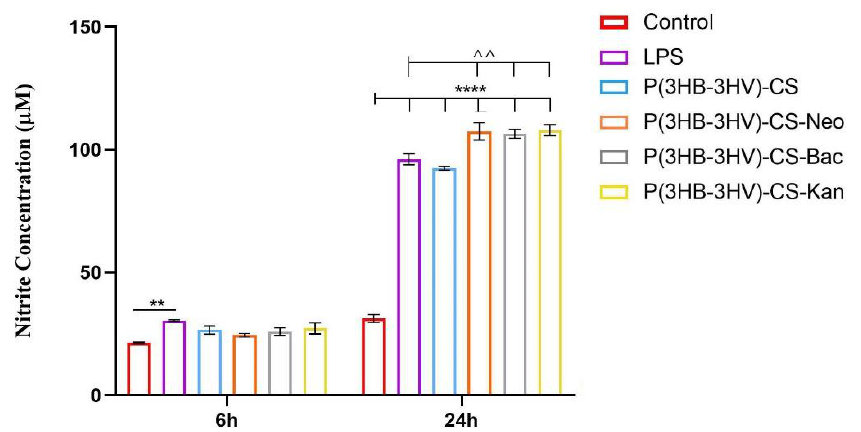
Figure 8. Graphic representation of the nitrite levels as a measure of NO release in LPS-activated RAW 264.7 macrophages cell cultures exposed for 6 h and 24 h to simple and Bac-/Neo-/Kan-loaded P(3HB-3HV)-CS spheres treatment. The represented data are the mean values of three independent experiments ± S.D. (** p ≤ 0.01 LPS vs. control; ˆˆ p < 0.01 sample vs. LPS; **** p ≤ 0.0001 sample vs. untreated